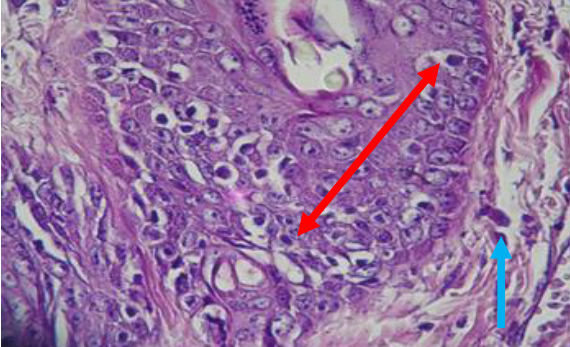
Figure, 15: section in skin of immunized animal at day 60 post challenge showed intense epidermal acanthosis accompanied with intracellular odema together with vascular dermatitis (H&E Stain 400X).